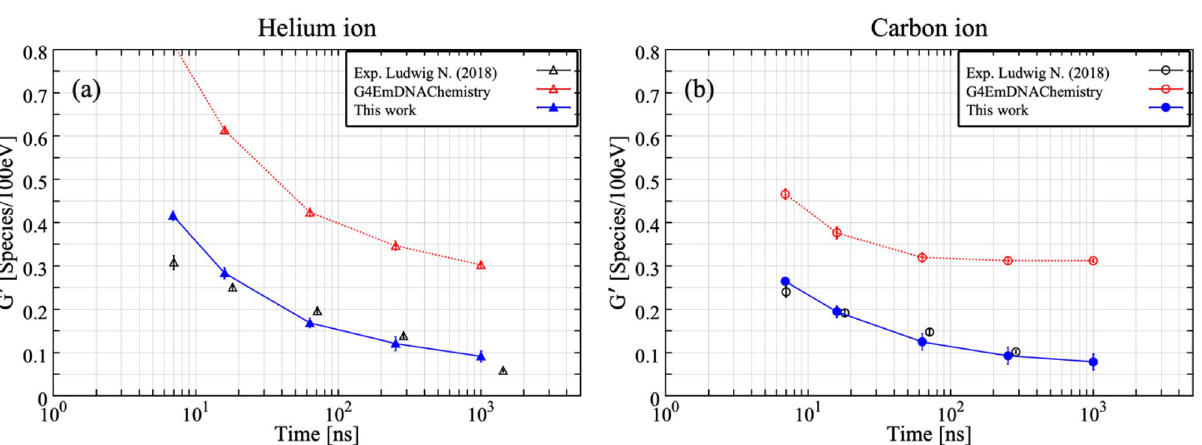
Figure 3. Time-dependent · OH yields for ( a ) 0.75 MeV/u helium ions and ( b ) 0.83 MeV/u carbon ions. Experimental data presented by Ludwig N. 17 were used for comparison with simulated time dependence of